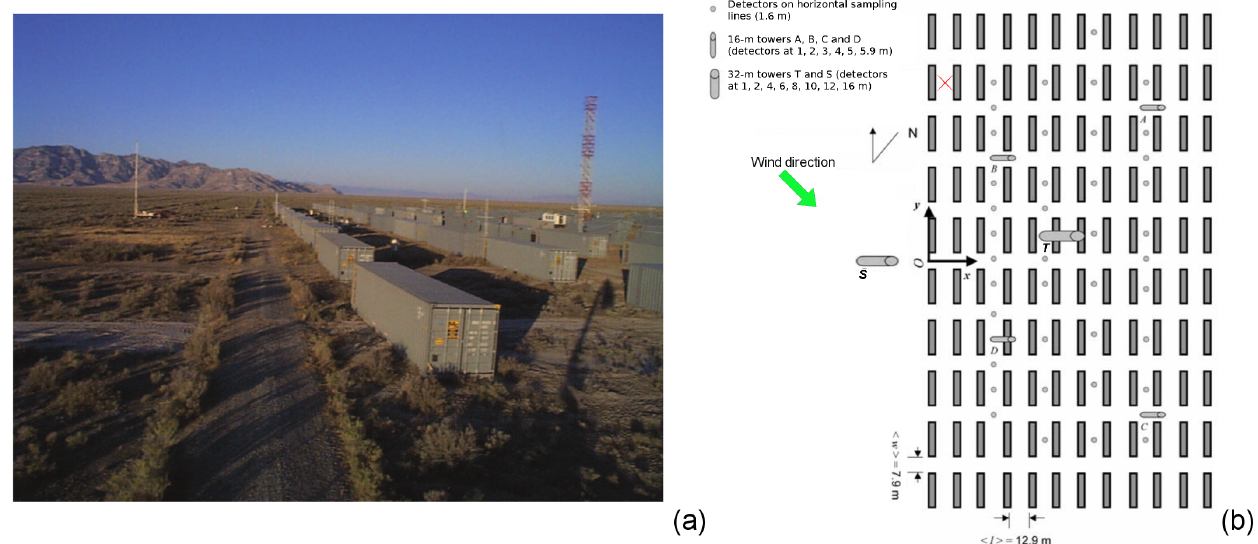
Figure 16. (a) Photograph of the MUST containers in Utah’s West Desert; (b) schematic representation of the container layout. The locations of the concentration (detectors) and wind sensors (S and T towers) are indicated, as are the position (red cross) of the pollutant release and the direction of the incoming flow (green arrow) for case 2681829. Source: Biltoft (2001) and Yee and Biltoft (2004).